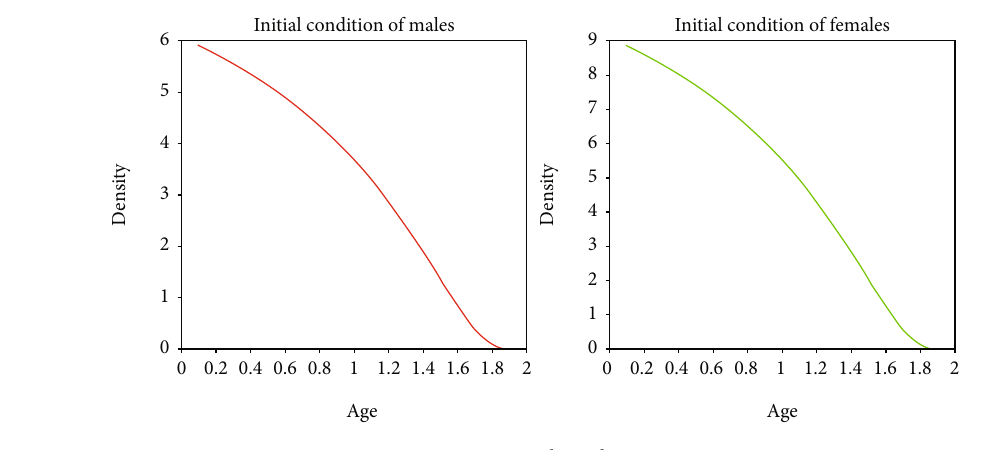
Figure 3: Initial